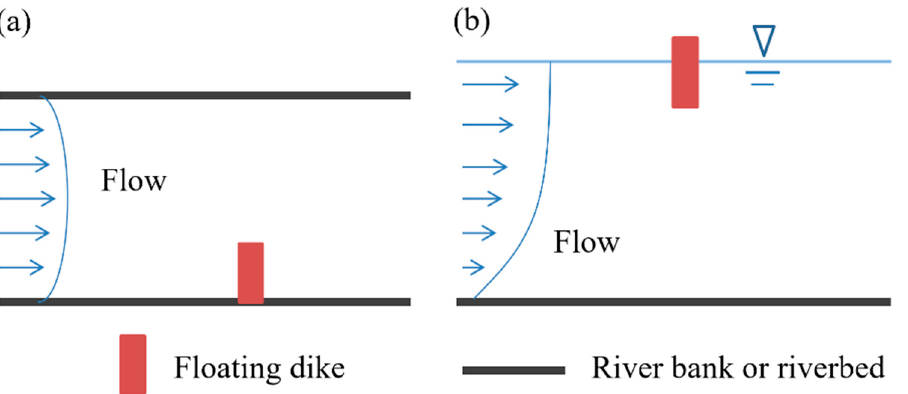
Figure 1. Floating dike: ( a ) plane view: the floating dike is attached to one side of the riverbank; ( b ) side view: the floating dike is floating on the water surface, moving only in the vertical direction (horizontal position is unchanged).